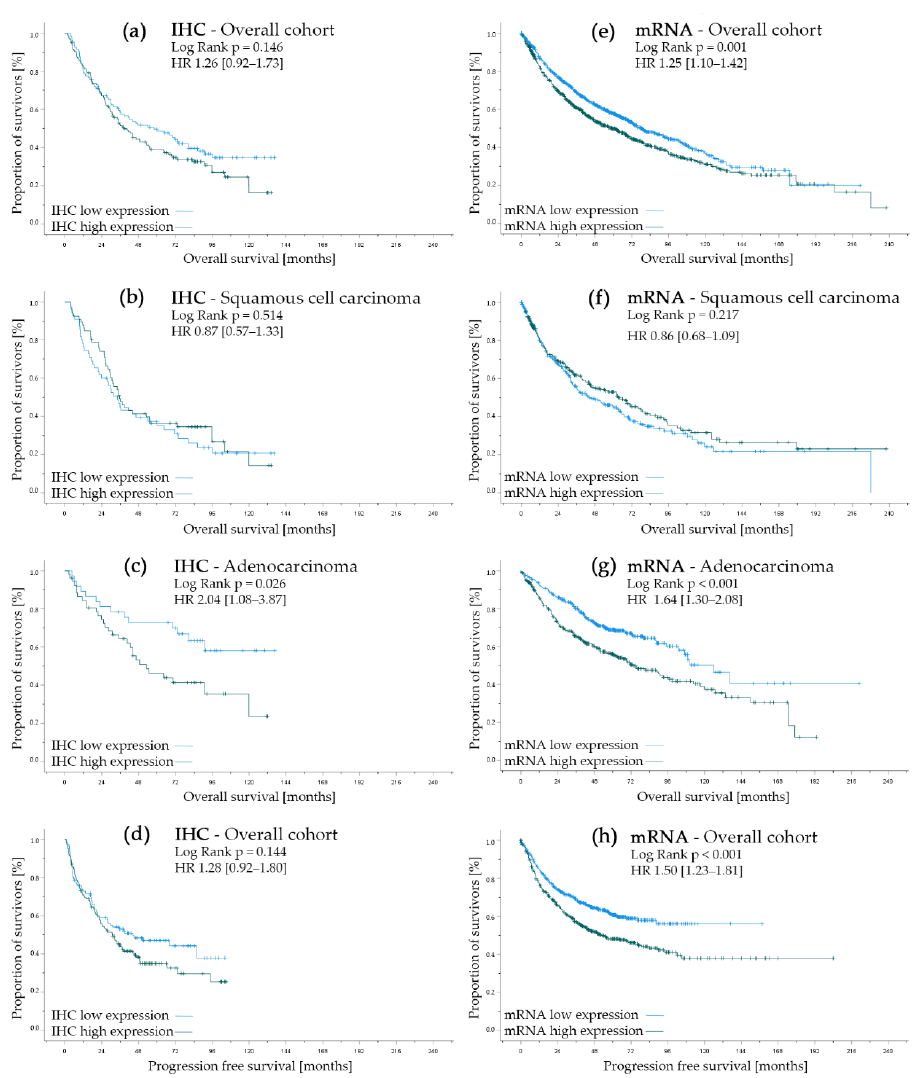
Figure 2. Univariate survival analysis regarding NT5DC2 expression. Left side ( a – d ) represents